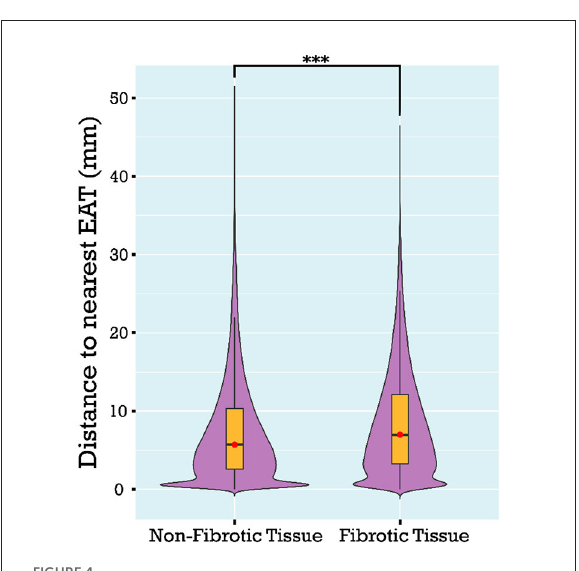
FIGURE4 Comparison of the distance to nearest EAT for fibrotic vs. non-fibrotic areas using a violin plot showing the median and interquartile ranges. Distance to nearest EAT was shorter for non-fibrotic compared to fibrotic points on the LA surface. EAT, epicardial adipose tissue; LA, left atrial (*** p <